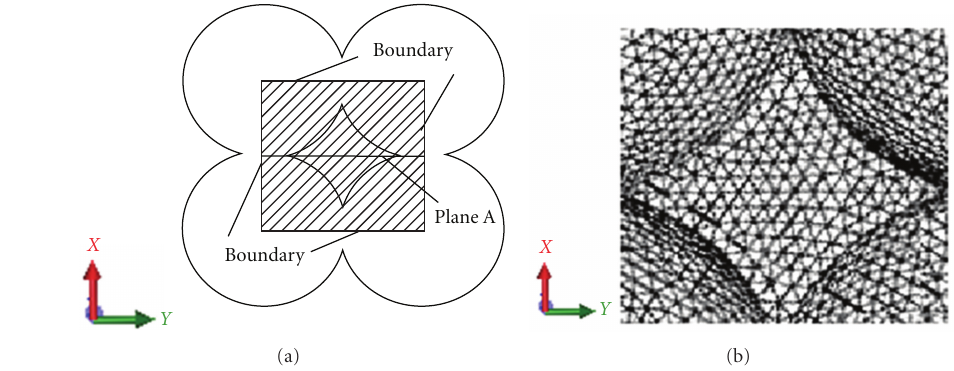
Figure 5: Schematic diagram of the computational domain.